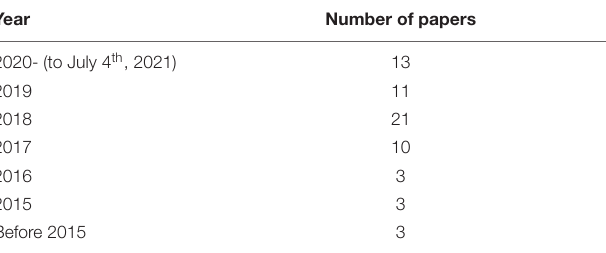
TABLE 2 | The number of publications per year contained within the scope of the